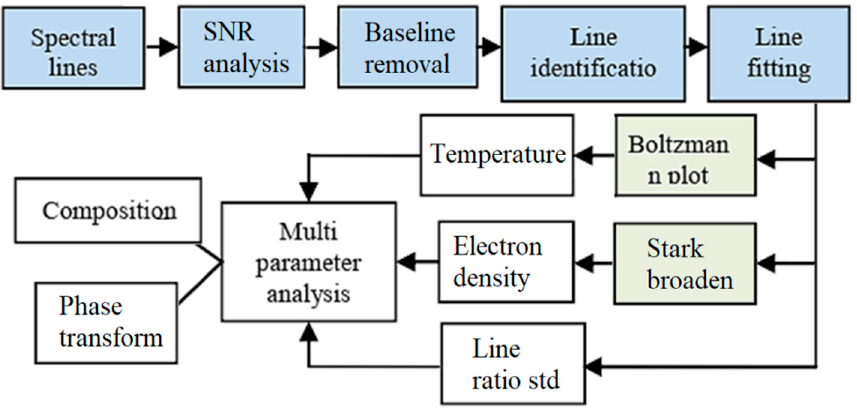
Figure 8. Pre-processing and multi-parameter analysis for monitoring of the composition and phase transformation [92].